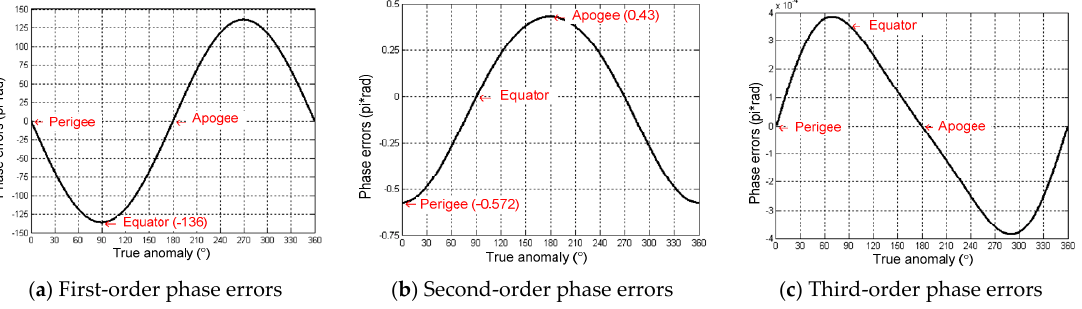
Figure 5. Phase errors of one orbit along with the true anomaly caused by the variations of semi-major axis ∆ a